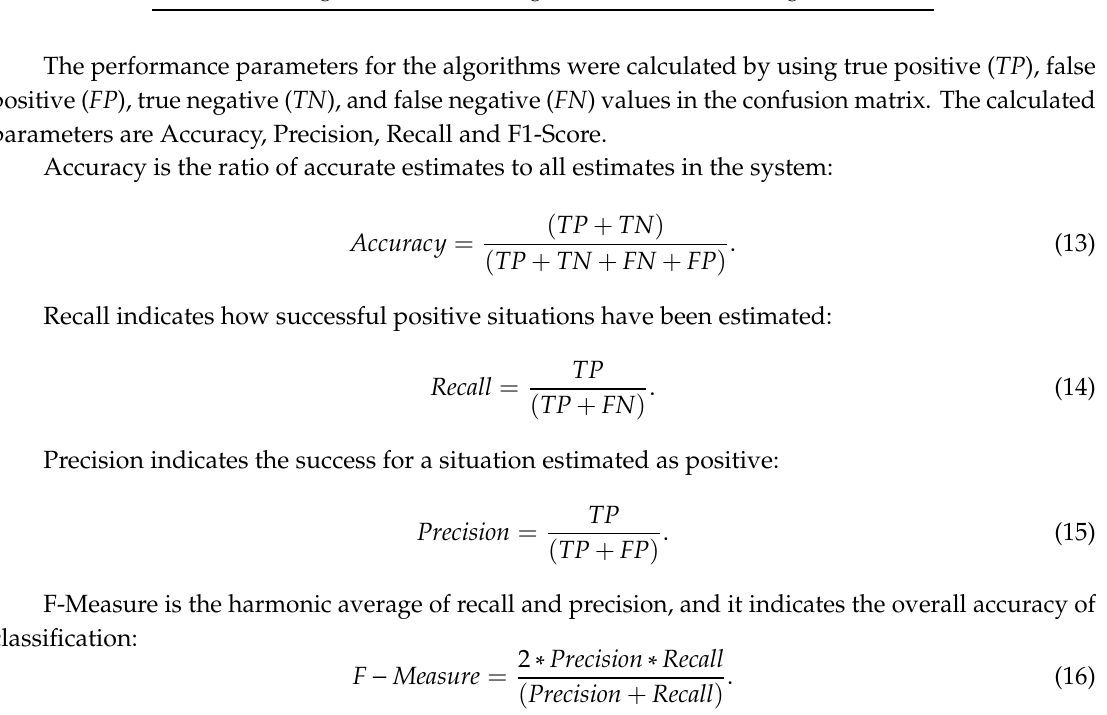
Table 5. Confusion matrix. Actual Positive Actual Negative Predictive